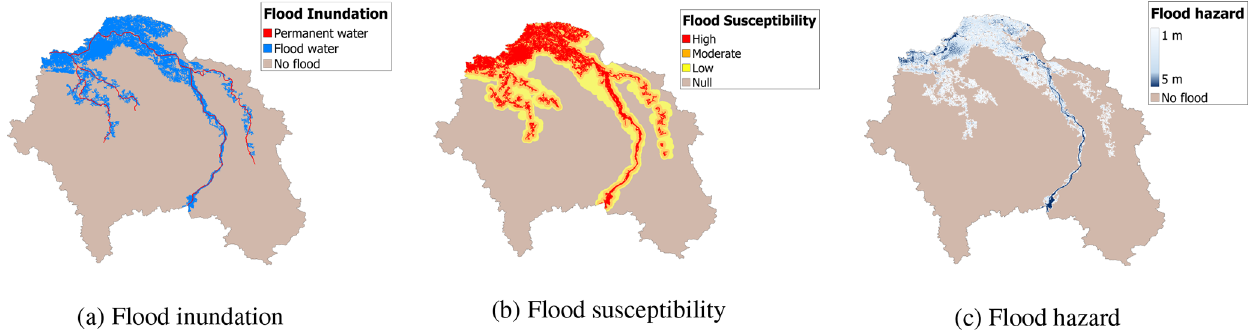
Figure 1. Examples of the types of flood maps analyzed for a representative area. Panel (a) shows a possible flood inundation map, panel (b) a flood susceptibility map, and panel (c) a flood hazard map, as defined in this